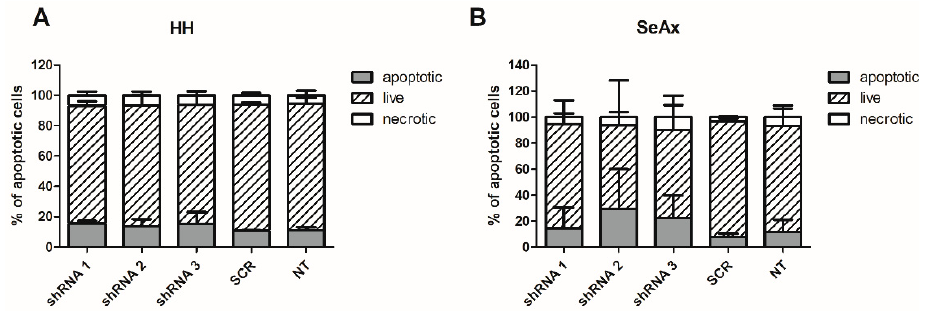
Figure 4. Cell viability upon TMEM244 knockdown in ( A ) HH; ( B ) SeAx cells. The percentages of apoptotic, live, and necrotic cells were determined using flow cytometry with Annexin V/7AAD staining. The mean values ± SD of 3 independent experiments are shown. NT—non-targeting, SCR—scrambled.